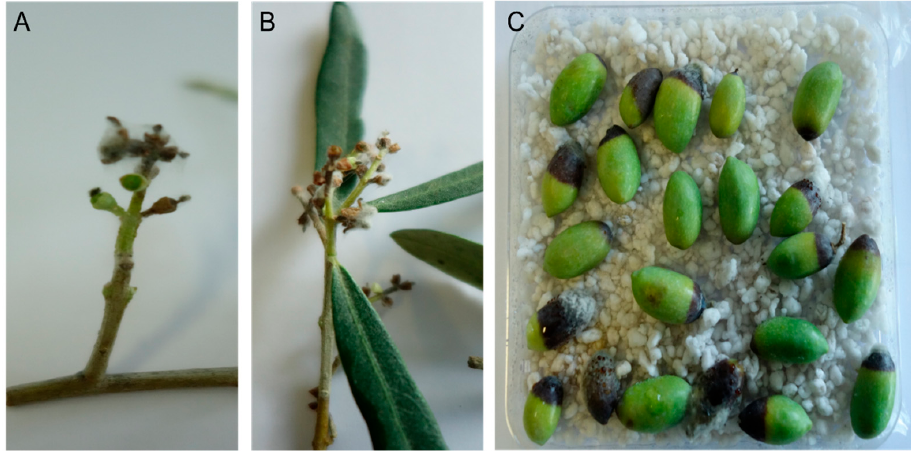
Figure 9. ( A , B ) Symptoms of anthracnose on olive blossoms 7 days after the artificial inoculation with Colletotrichum acutatum and ( C ) on young olive fruit exposed to diquat treatments.